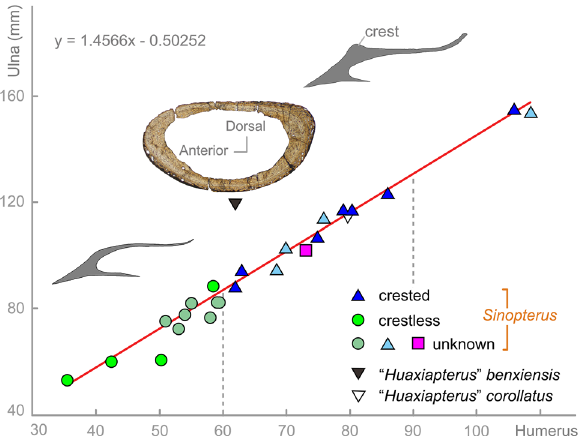
Figure 5. Plot of the ulna length relative to the humerus length in Jehol tapejarids with the presence of premaxillary crest indicated. Purple square represents SDUST-V1014. Histological cross-section reconstructed from the first wing phalanx of SDUST-V1014. Rostrum outlines are based on PMOL-AP00008 (crestless) and AP00025 (crested). Data provided in “Supplementary